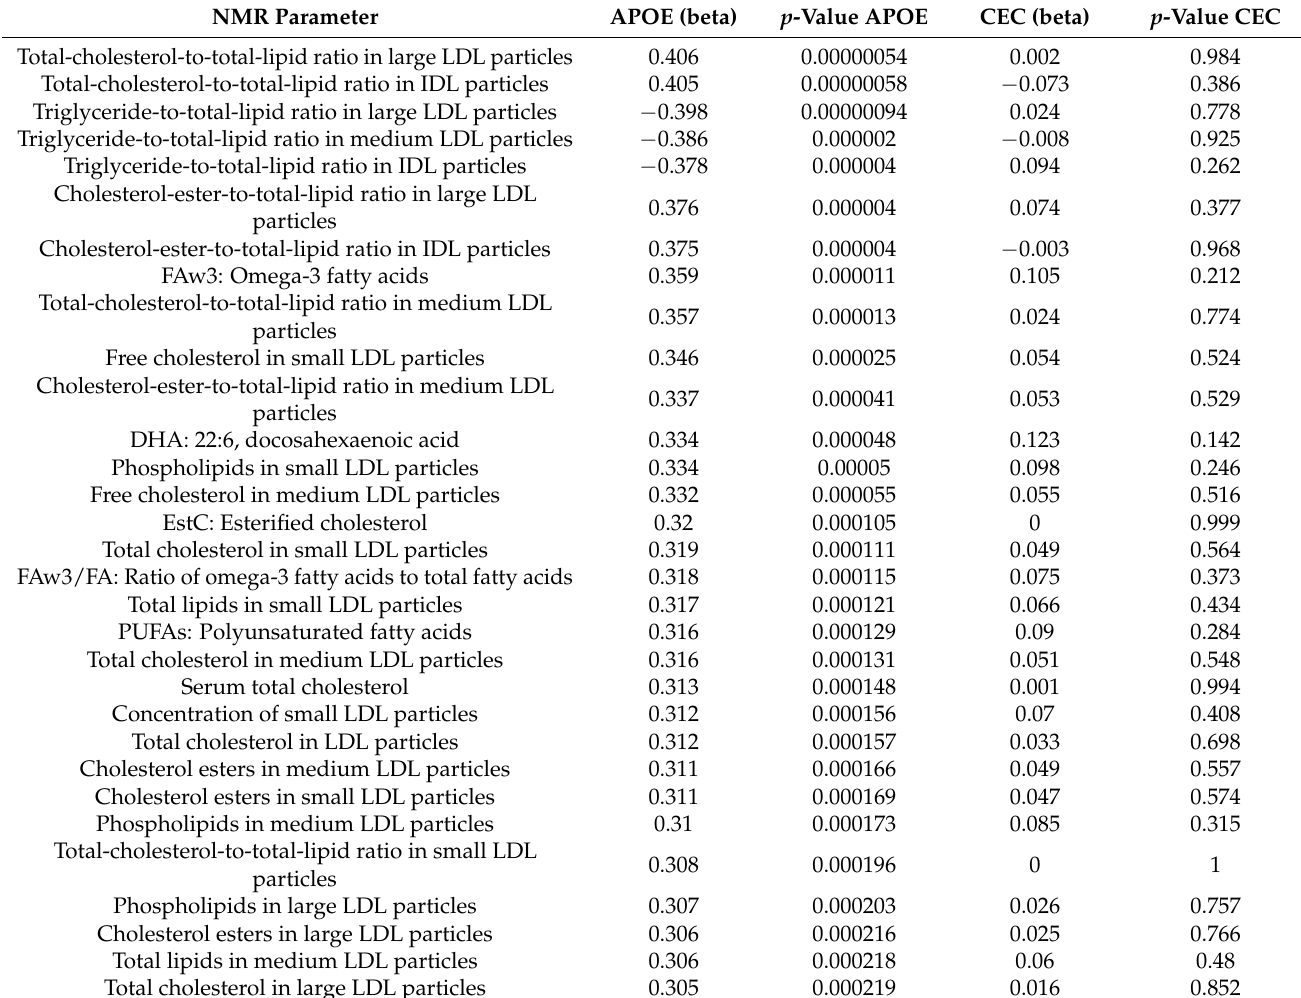
Table 2. NMR features associated with the APOE locus and their effect on the